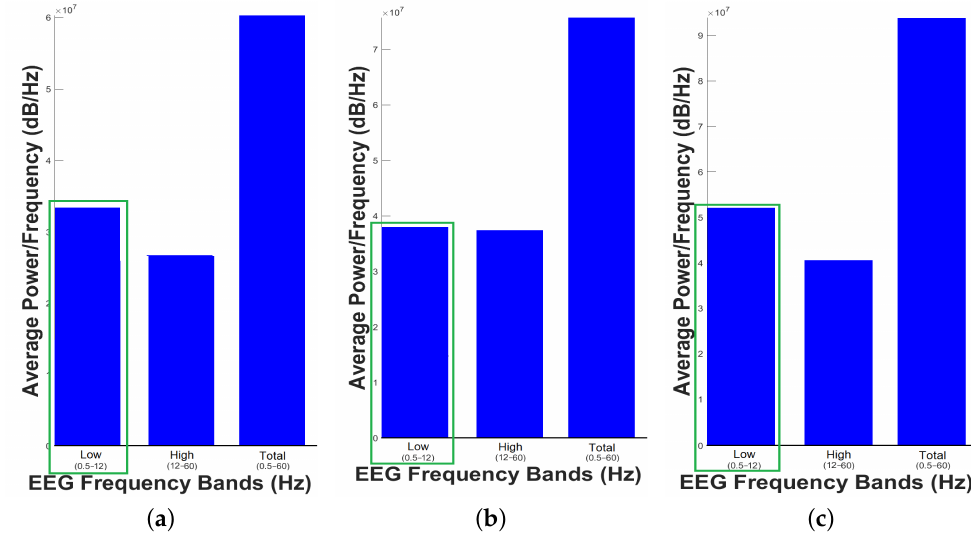
Figure 3. Average Power Spectrum Density. ( a ) First sample, ( b ) Second Sample and ( c ) Third